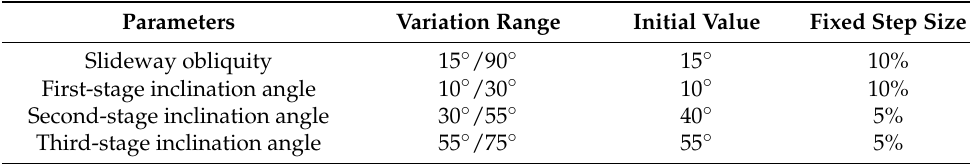
Table 7. Variation range and initial value of four parameters.